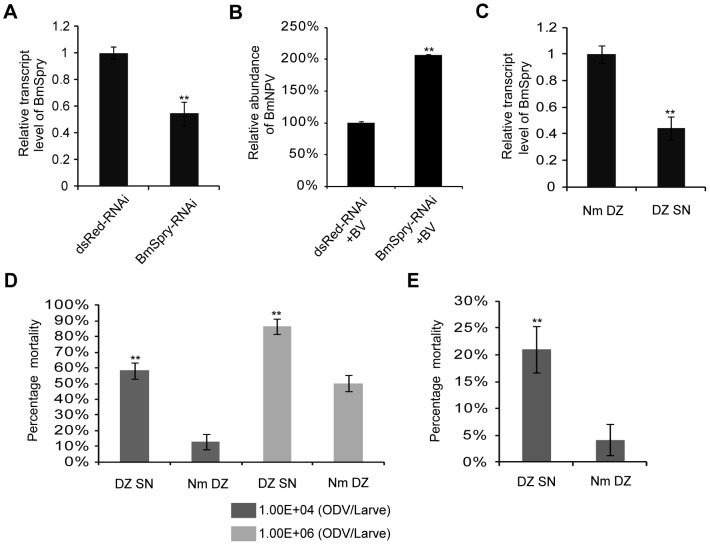

BmSpry was essential for antiviral defense in vivo.(A) The silkworm Nm DZ line was used for the RNAi experiment. Injection of dsRNA is indicated, the dsRNA of dsRed was used as a negative control with dsRNA of BmSpry as the experimental group. At 3 days post-injection of dsRNA, total RNA was extracted for qPCR to measure the expression level of BmSpry. Data are given as mean ±SD (n = 3). (B) Nm DZ silkworms treated with dsRNA against the indicated genes were infected with BmNPV (106 pfu/mL) by stab inoculation for 3 days and processed for qPCR. Data are given as mean ±SD (n = 3). (C) Analysis of the expression level of BmSpry in Nm DZ and the mutant DZ SN. Total RNA extracted from newly exuviated Nm DZ and DZ SN 5th instar larvae was used for qPCR. Data are given as mean ±SD (n = 3). (D) Analysis of mortality of DZ SN and Nm DZ after oral inoculation with BmNPV. Nm DZ and DZ SN newly exuviated 4th instar larvae were used for this experiment. DZ SN and Nm DZ silkworms were infected with BmNPV per os using a dose of 104 or 106 OB/larva and mortality was monitored until the adult stage (22 days). (E) Newly exuviated 2nd-instar larvae were used to investigate mortality after inoculation per os with 5×103 OB/larva. Mortality was monitored until the pupa stage (16 days). A representative of triplicate experiments is shown. Statistically significant differences: ** P<0.01.